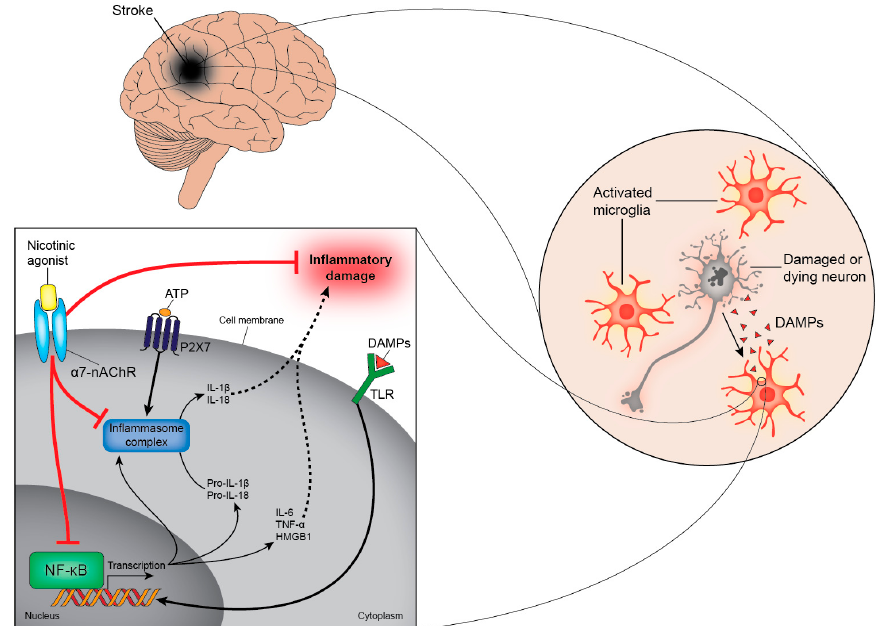
Figure 2. Activation of α 7-nAChRs reduces inflammation. Damaged and dying cells in the brain release DAMPs after a stroke. DAMPs can bind to several receptors, including TLRs, cytokine receptors, and the receptor for advanced glycation end products (RAGE). Ligation of these receptors activates NF- κ B to translocate to the nucleus (bold arrow) where it induces the transcription of genes that code for pro-inflammatory cytokines, such as IL-6, IL-8, TNF- α and HMGB1. In addition, activation of NF- κ B stimulates the production of the immature forms of IL-1 β and IL-18 (pro-IL-1 β and pro-IL-18, respectively). These biologically-inactive cytokines are cleaved to their active form by inflammasomes and are subsequently secreted from the cell (dashed arrows). These intracellular multi-protein complexes assemble in response to NF- κ B stimulation and require a second stimulus (such as ATP) to become activated. α 7-nAChR agonists interfere with these pathways and prevent the secretion of pro-inflammatory cytokines by inhibiting NF- κ B and inflammasome activation (bar-headed red lines). α 7-nAChRs, α 7-nicotinic acetylcholine receptor; DAMPs, damage-associated molecular patterns; TLRs, toll-like receptors; NF- κ B, nuclear factor kappa B; IL, interleukin; TNF- α , tumour necrosis factor- α ; HMGB1, high-mobility group box 1; ATP, adenosine triphosphate.